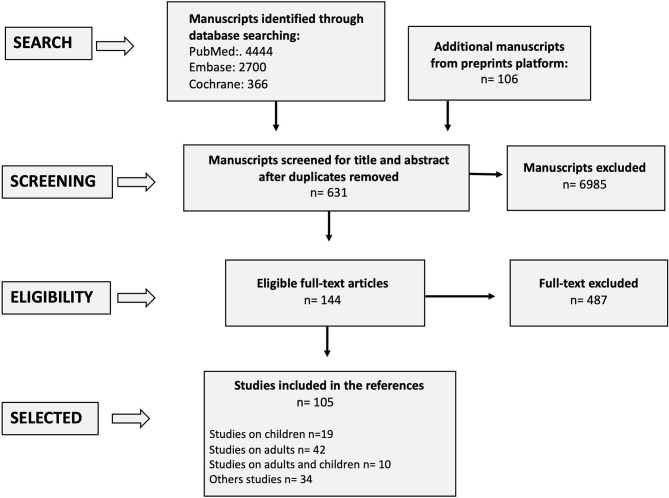
PRISMA flowchart.